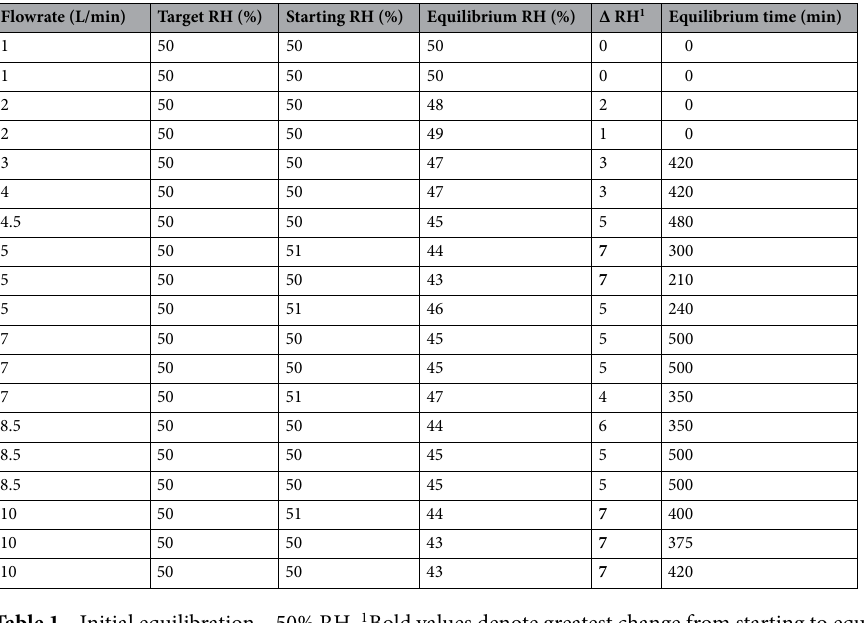
Table 1. Initial equilibration—50% RH. 1 Bold values denote greatest change from starting to equilibrium